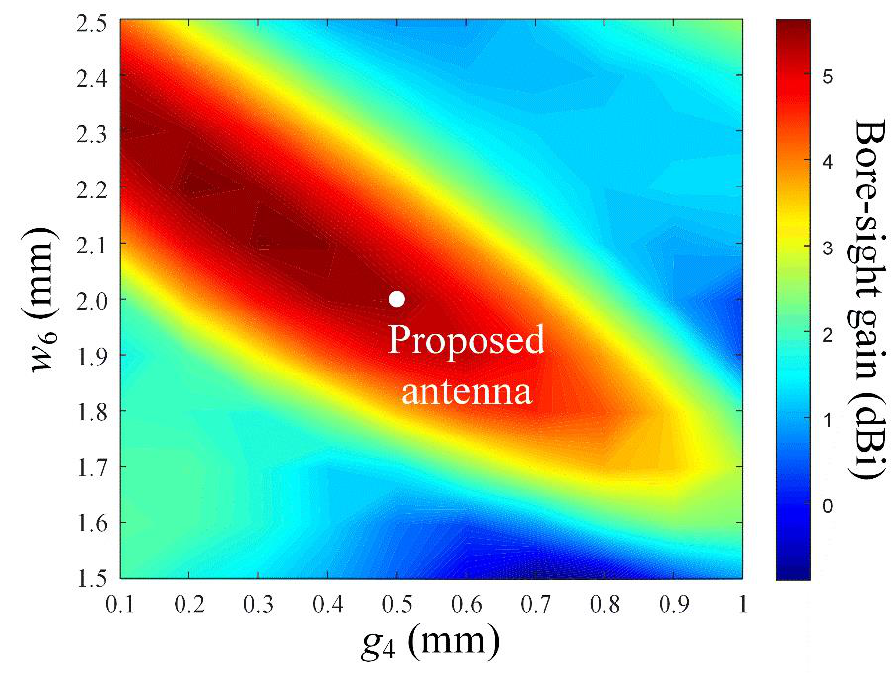
Figure 7. Bore-sight gain in accordance with parameters g 4 and w 6 . Figure 9a,b present the maximum gain and the main lobe direction θ 0 of the conven- tional printed monopole antenna in comparison with the proposed antenna according to the glass thickness t . For the conventional monopole antenna, the trends of the maximum gain and main lobe direction are considerably irregular. In particular, at a conventional